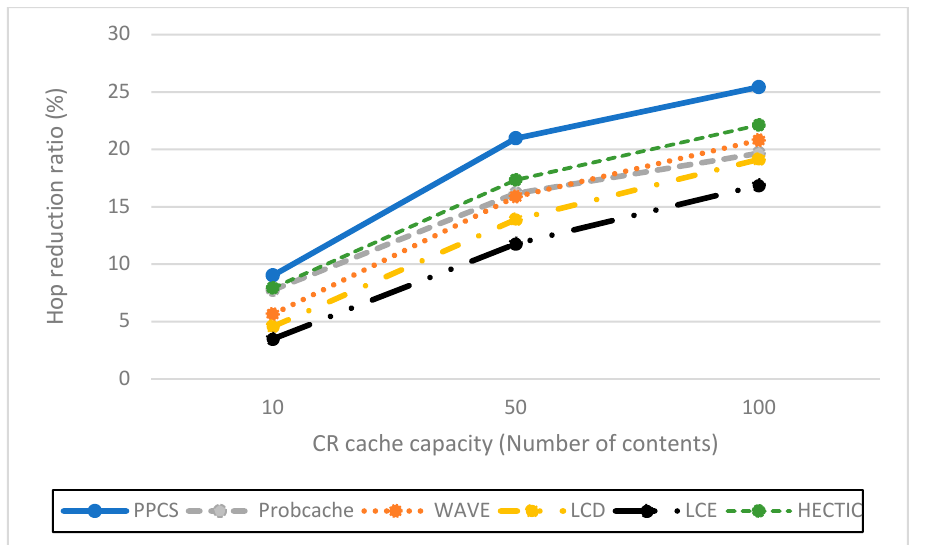
Figure 5. Hop reduction ratio versus different CS sizes. Figure 4. Hop reduction ratio versus different CS